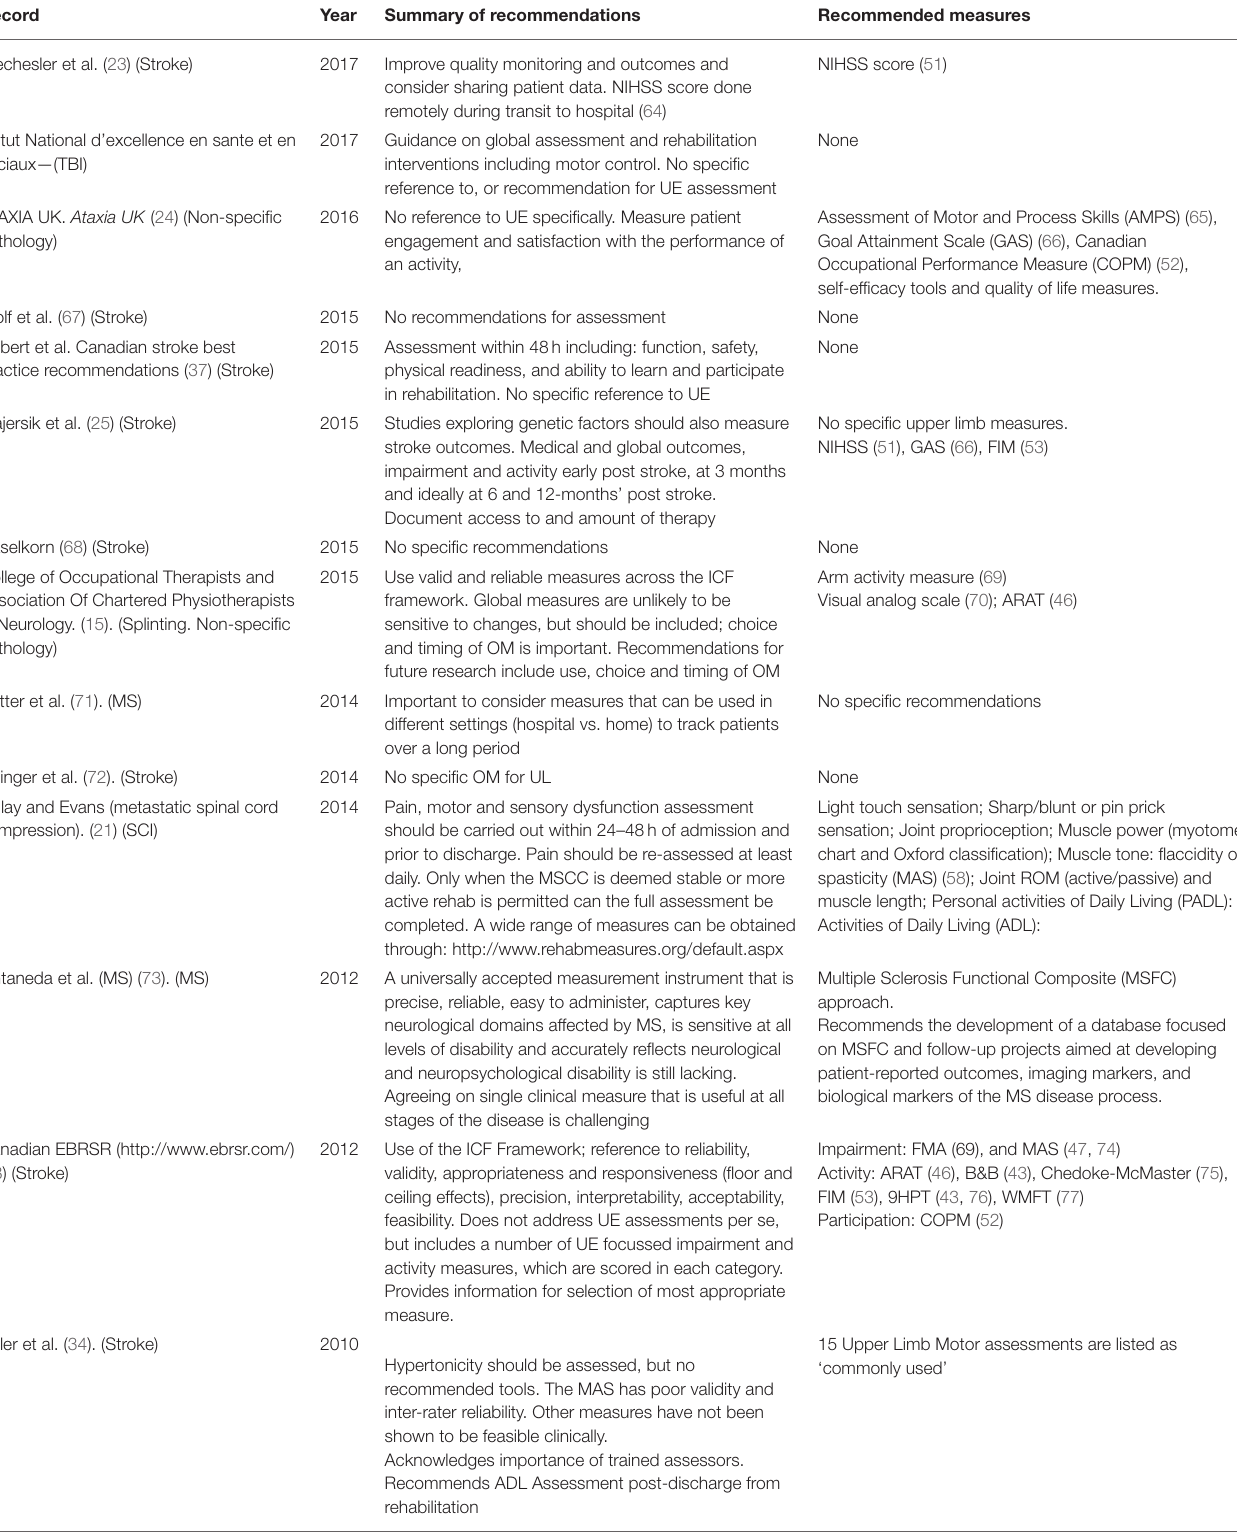
TABLE 2 | Summary of the peer reviewed and practice guideline records included in the